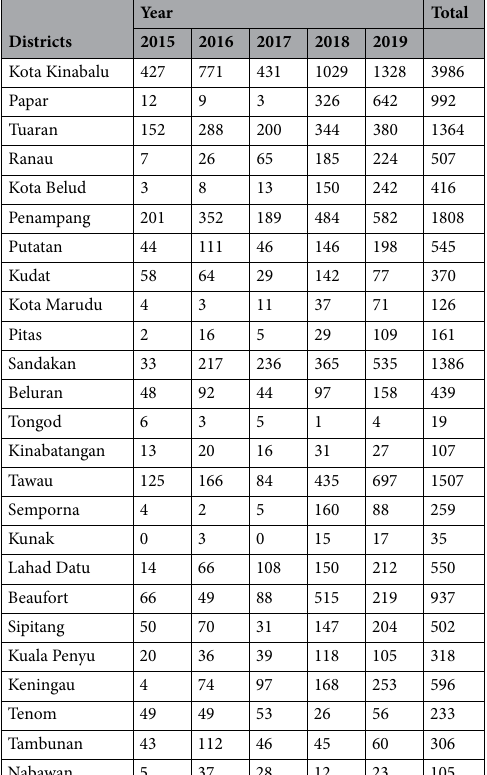
Table 2. The number of hand, foot, and mouth disease cases in each district of Sabah from 2015 to